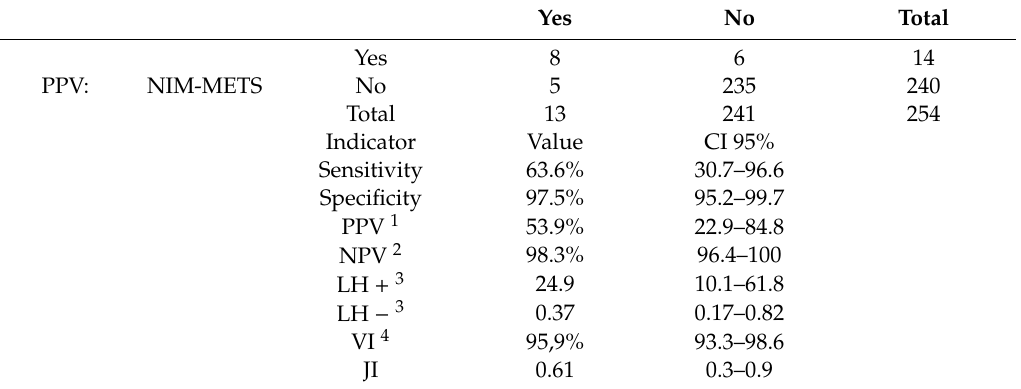
Table 3. Diagnostic accuracy of NCEP-ATP III for MetS in childhood and adolescent population. Yes No